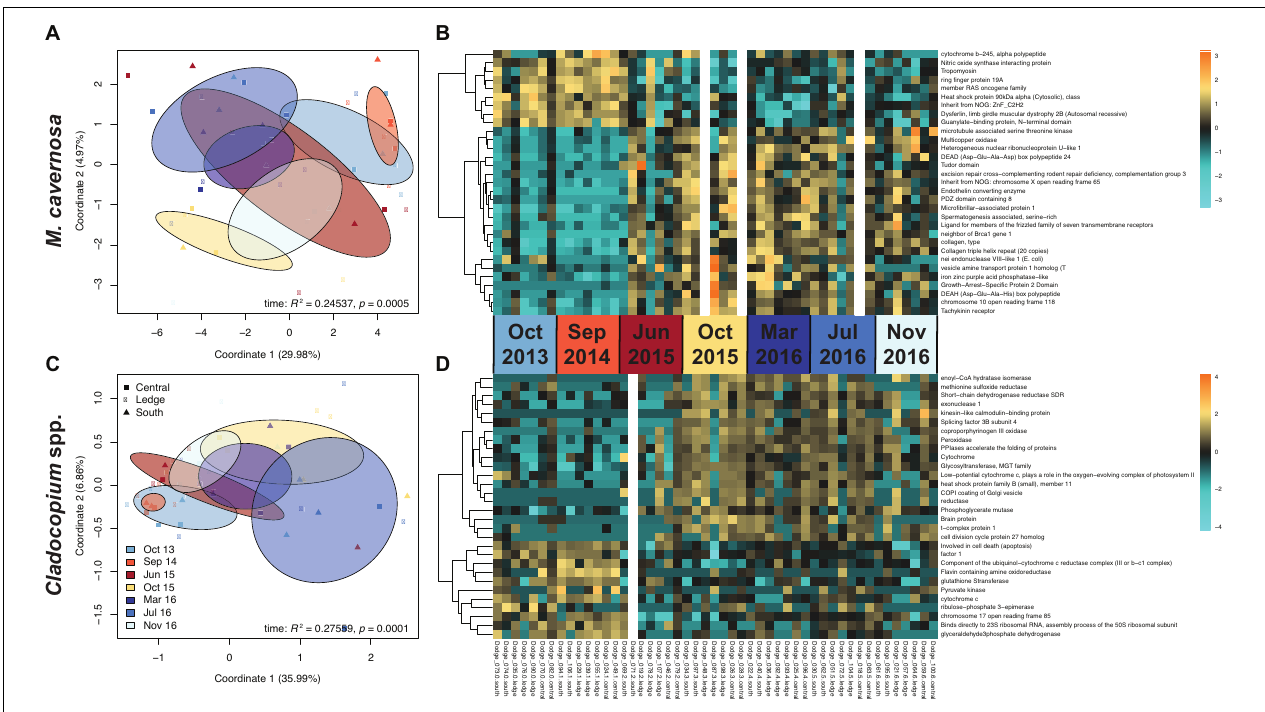
FIGURE 2 | (A,C) PCoAs of coral host and symbiont datasets depicting transcriptomic variation through time from the in situ experiment. Colors correspond to sampling time point, where warmer colors represent periods of relatively low estuarine discharge (South Florida Water Management District DBHYDRO; September March 2016: 70.52 m 3 s - 1 , July 2016: 59.37 m 3 s - 1 , November 2016: 33.31 m 3 s - 1 ). Ellipses denote the dispersion of each time point’s samples, and sites are indicated by point shapes. Test statistics and p values were generated from PERMANOVAs in vegan. (B,D) Heatmaps of the most highly significant DEGs, organized by site within time points using a Benjamini-Hochberg-corrected p value cutoff of 1e - 6 for host and 0.01 for symbiont datasets. Gaps represent outlier samples removed from each dataset. Increasing intensities of gold indicate higher expression of genes in samples, while increasing intensities of turquoise indicate lower